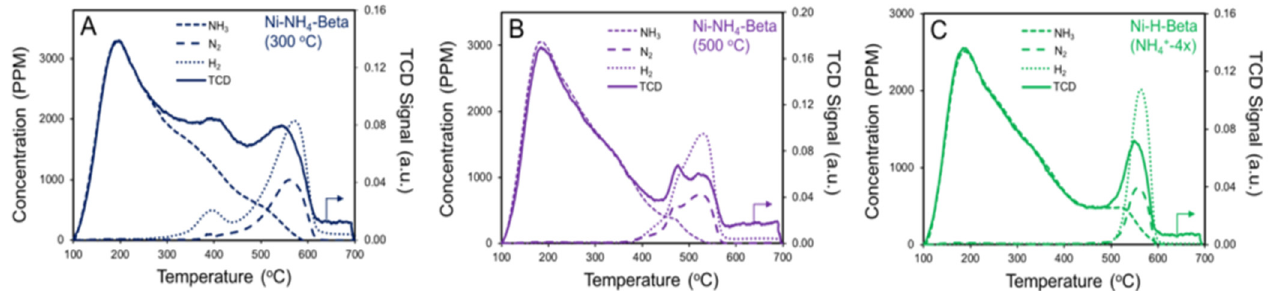
Figure 8. NH 3 TPD using online QMS. ( A ) Ni-NH 4 -Beta pretreated in situ at 300 °C, ( B ) Ni-NH 4 -